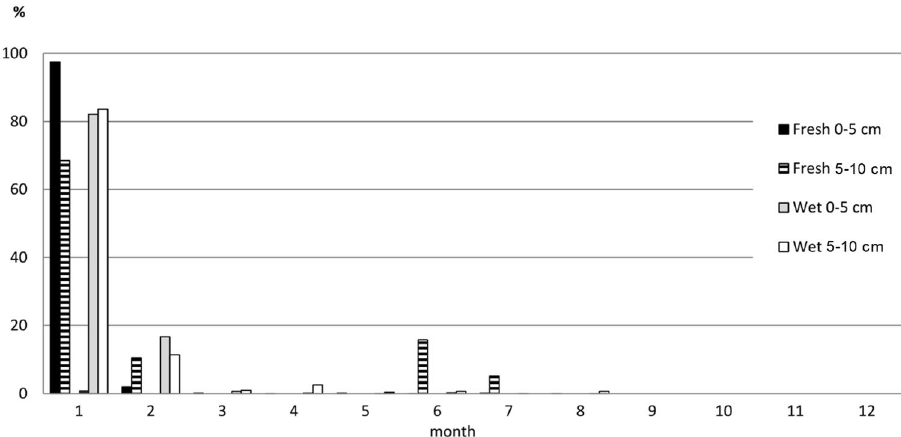
Figure 3. Percentage of R. laciniata seedlings appearing in the upper (0–5 cm) and lower (5–10 cm) soil layers in the following months of the experiment.